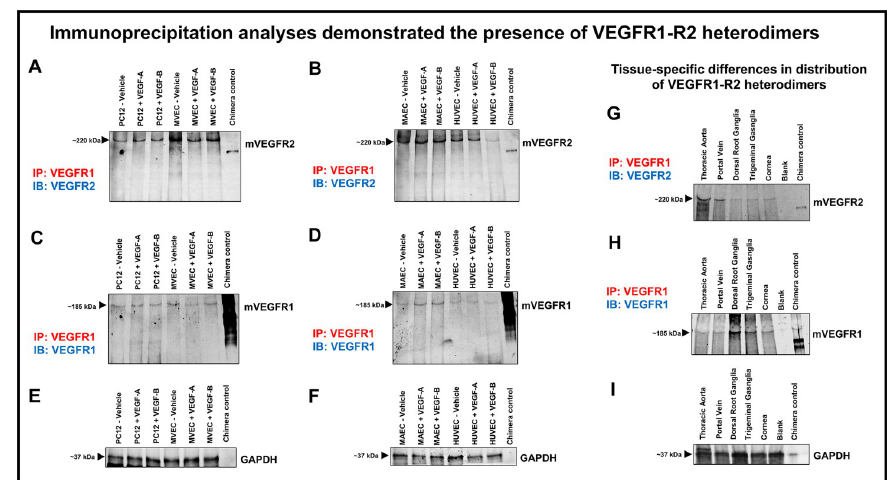
Fig 3. Immunoprecipitation / pulldown assays confirm presence of VEGFR1-R2 heterodimers. (A) Immunoblot showing VEGFR2 protein bands in PC12 neuronal and MVEC cell lysates immunoprecipitated with anti-VEGFR1 antibody (B) Immunoblot showing VEGFR2 protein bands in MAEC and HUVEC cell lysates immunoprecipitated with VEGFR1 antibody (C) Immunoblot from (Panel A), washed and reprobed with anti-VEGFR1 antibody showed VEGFR1 protein bands (D) Immunoblot from (Panel B) washed and reprobed with anti-VEGFR1 antibody confirming VEGFR1 pulldown. Cell lysates from PC12 neuronal cells as well as MAEC, MVEC and HUVECs when immunoprecipitated with anti-VEGFR1 antibody demonstrated the existence of VEGFR1-R2 heterodimers when probed with anti-VEGFR2 antibody (E, F) Immunoblots showing GAPDH, used as a loading control (G) Immunoblot showing VEGFR2 protein bands in tissue lysates immunoprecipitated with anti-VEGFR1 antibody confirm VEGFR1-R2 heterodimers. (H) VEGFR1 protein bands in tissue lysates confirmed VEGFR1 pulldown (I) GAPDH was used as a loading